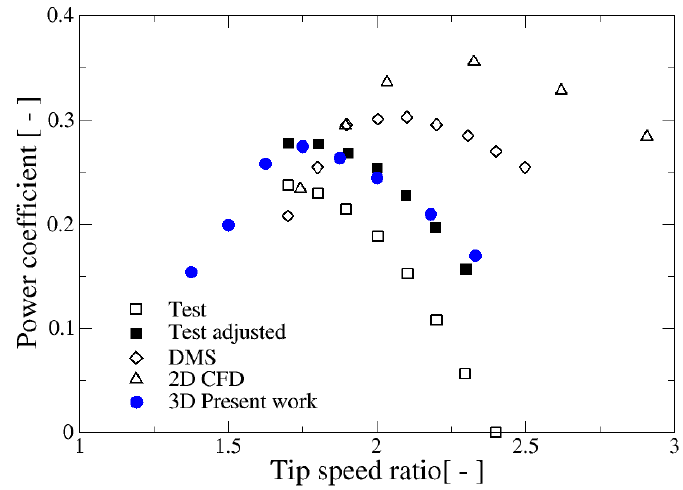
Figure 3. Power coefficient versus tip speed ratio curves for the performed computations versus the measurements of [2]. In addition, the curves obtained with 2D CFD simulations and the DMS model are shown for comparison.